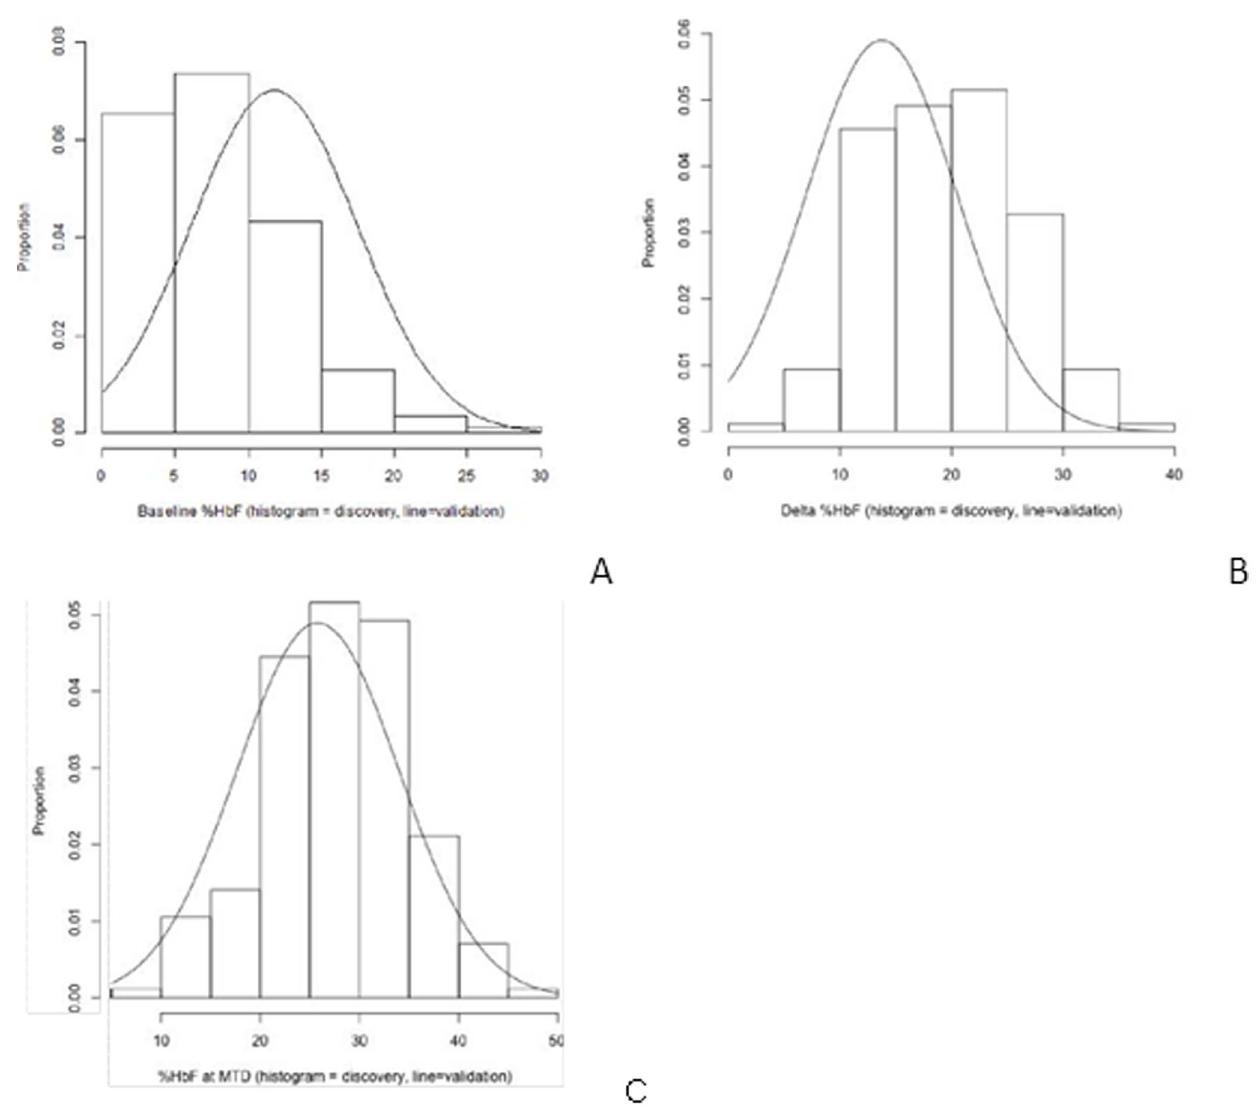
Figure 1. Comparison of discovery and validation cohorts. A, Baseline, or endogenous HbF for the discovery cohort is shown in binned histogram, and distribution of baseline HbF in validation cohort by a line plot. B, Delta HbF for the discovery cohort is shown in binned histogram, and distribution of delta HbF in validation cohort by a line plot. C, Final, or MID HbF for the discovery cohort is shown in binned histogram, and distribution of final, or MID in validation cohort by a line plot.